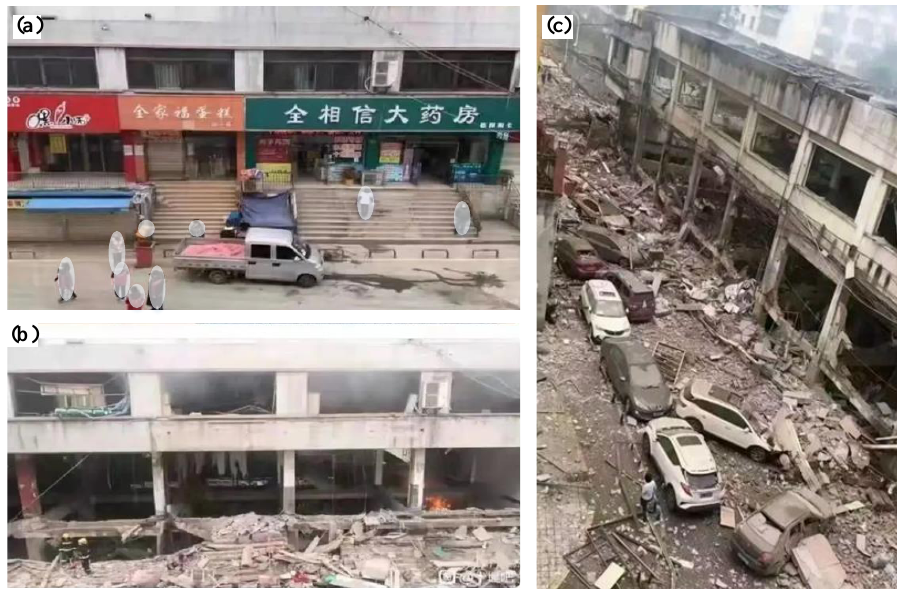
Figure 4. ( a ) Market building before the explosion; ( b ) Market building destroyed by explosion; ( c ) ( c ) Market street impacted by the blast (source: https://baijiahao.baidu.com/s?id=1702438248131929 294&wfr=spider&for=pc, accessed on 14 August 2021).